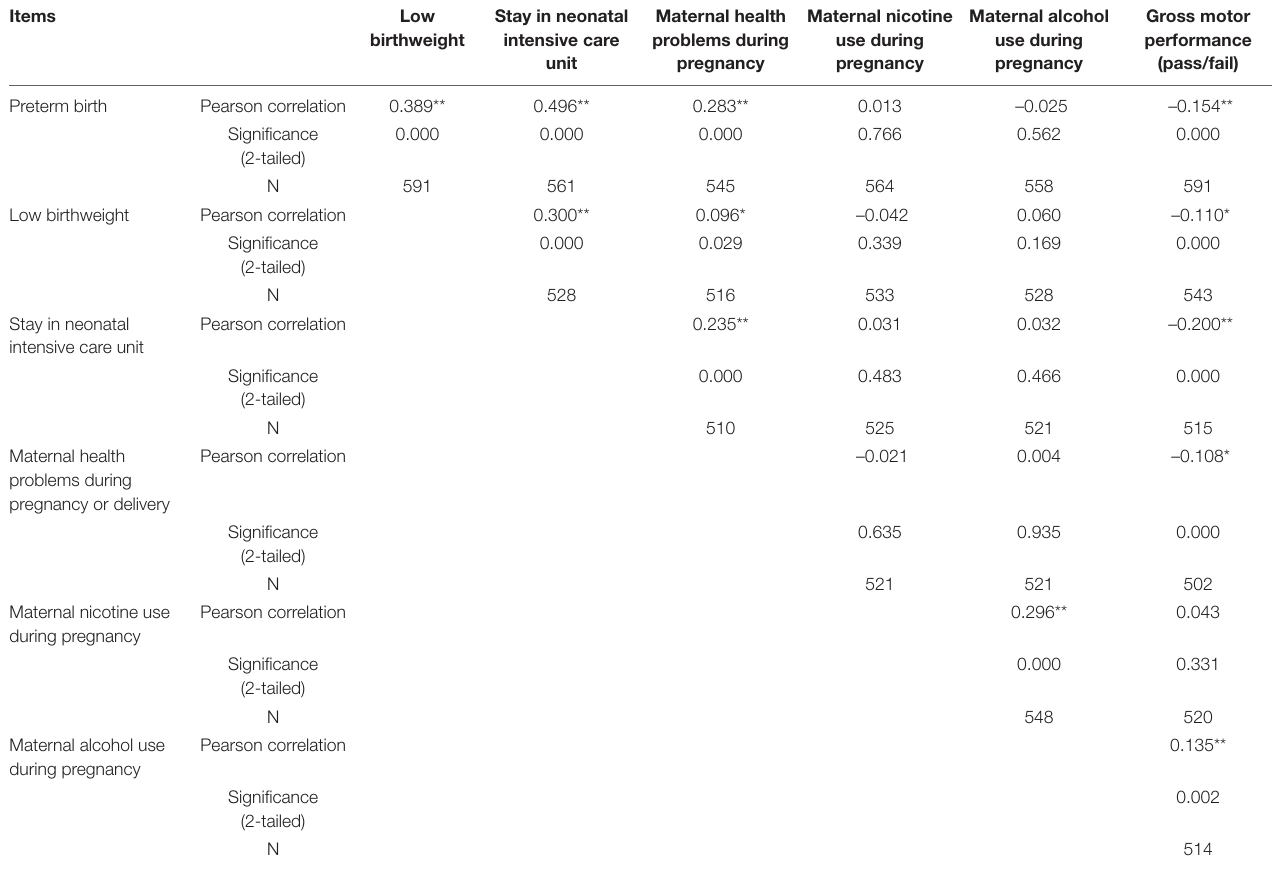
TABLE 2 | Correlation matrix between gross motor performance and risk factors for development. Items Low